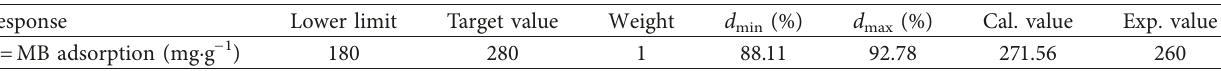
Figure 1: Variation of the methylene blue adsorption as a function of (a) impregnation ratio and carbonization temperature, (b) im- pregnation ratio and carbonization time, and (c) carbonization temperature and carbonization time. Table 4: Characteristics of maximum for response Y.